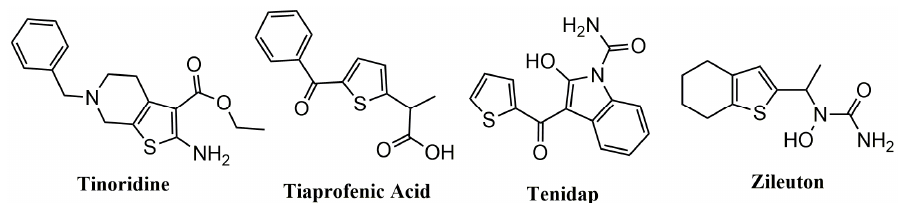
Figure 1. Chemical structures of market anti-inflammatory drugs containing a thiophene moiety (Tinoridine, Tiaprofenic acid, Tenidap and Zileuton.).